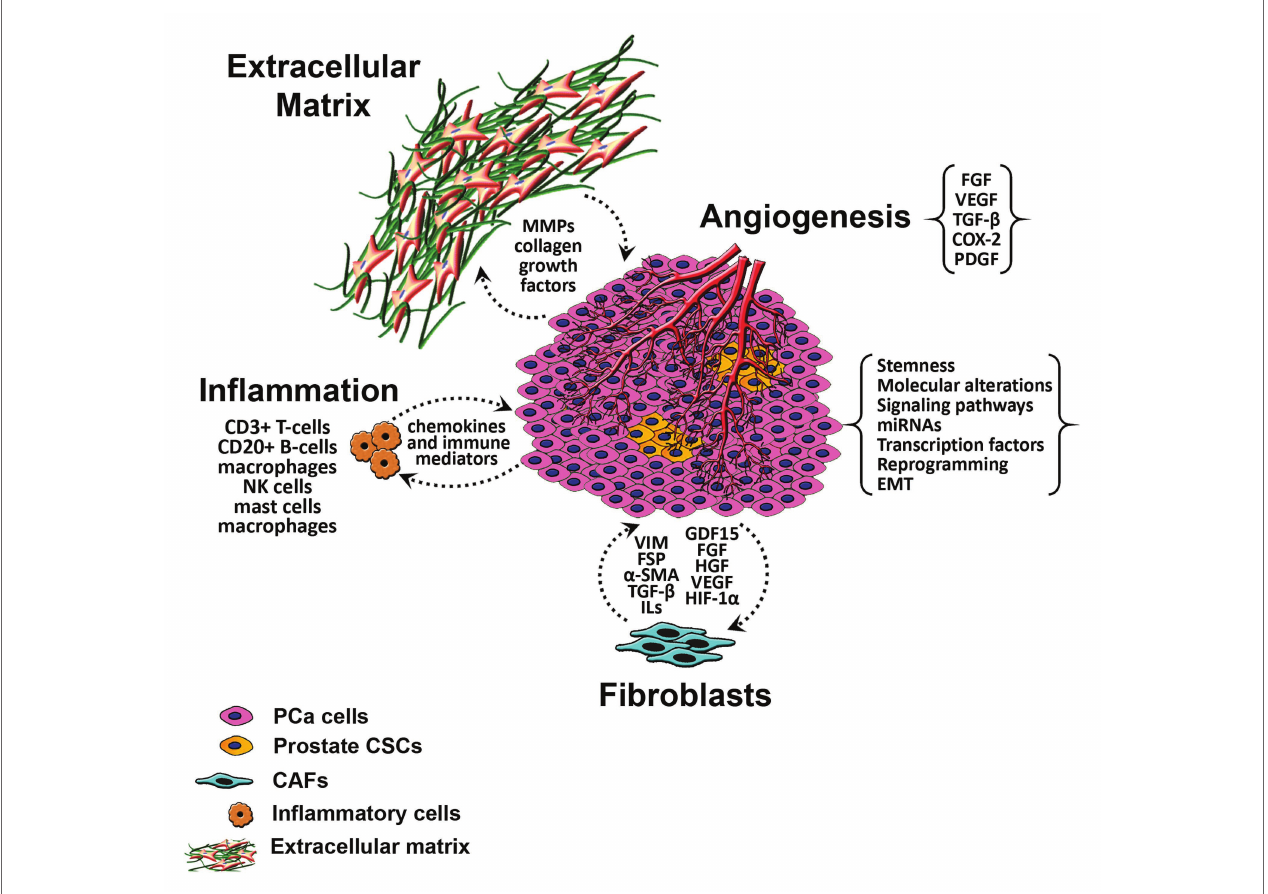
FIGURE 1 | Schematic diagram of the tumor microenvironment in PCa. α -SMA, alpha smooth muscle actin; CAFs, cancer associated fibroblasts; CSCs, cancer stem cells; COX-2, cyclooxygenase-2; ECM, extracellular matrix; EMT, epithelial-to-mesenchymal transition; FGF, fibroblast growth factor; FSP, fibroblast specific protein; GDF15, growth differentiation factor 15; HGF, hepatocyte growth factor; ILs, interleukins; miRNAs, micro-RNAs; MMP, matrix metalloproteinases; NK cells, natural killer cells; PCa, prostate cancer; PDGF, platelet-derived endothelial cell growth factor; TGF- β , transforming growth factor beta; VEGF, vascular endothelial growth